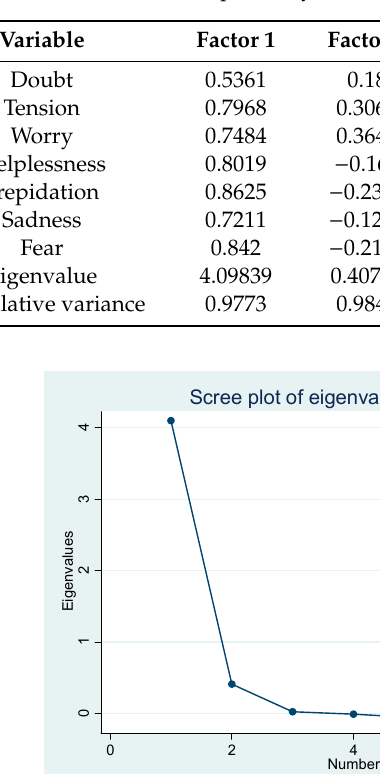
Table 1. Exploratory factor analysis of panic.